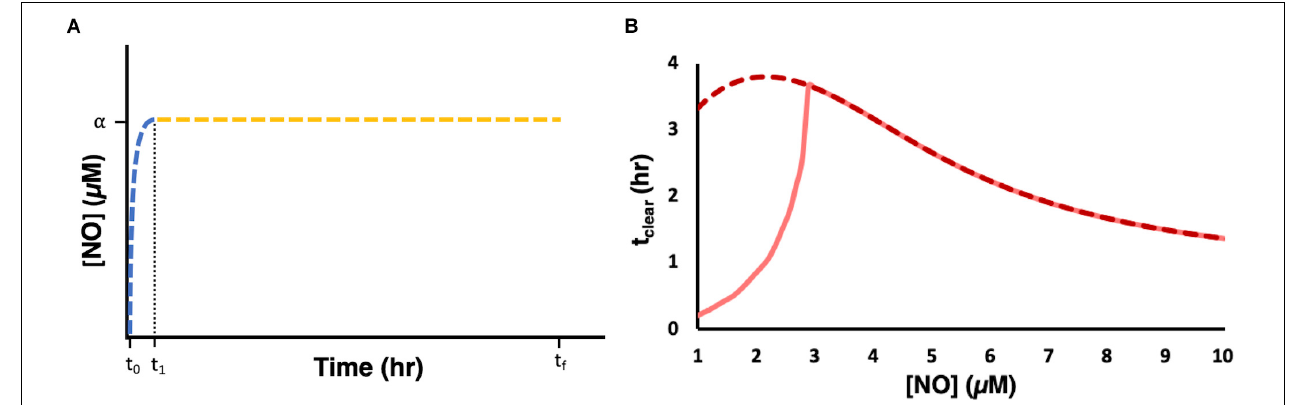
FIGURE 7 | Designing and implementing delivery schemes to maintain steady state [NO]. (A) For a desired NO concentration α and payload ω , a bolus delivery was introduced at t 0 such that the [NO] profile (blue dashed line) peaked at [NO] = α at t 1 . At t 1 a dosing regime was implemented to maintain d [ NO ] / dt = 0 and [NO] = α up until t f (yellow dashed line), at which point the payload ω was exhausted. (B) Steady state dosing regimes were simulated at [NO] between 1 and 10 µ M for a payload of 24 µ mol and t clear was measured (dark red dashed line). The light shaded solid red line represent the relationship between t clear and [NO] when implementing a step function delivery approximation. All simulations were performed using the optimal parameter set (ER = 1, minimum SSR, 1